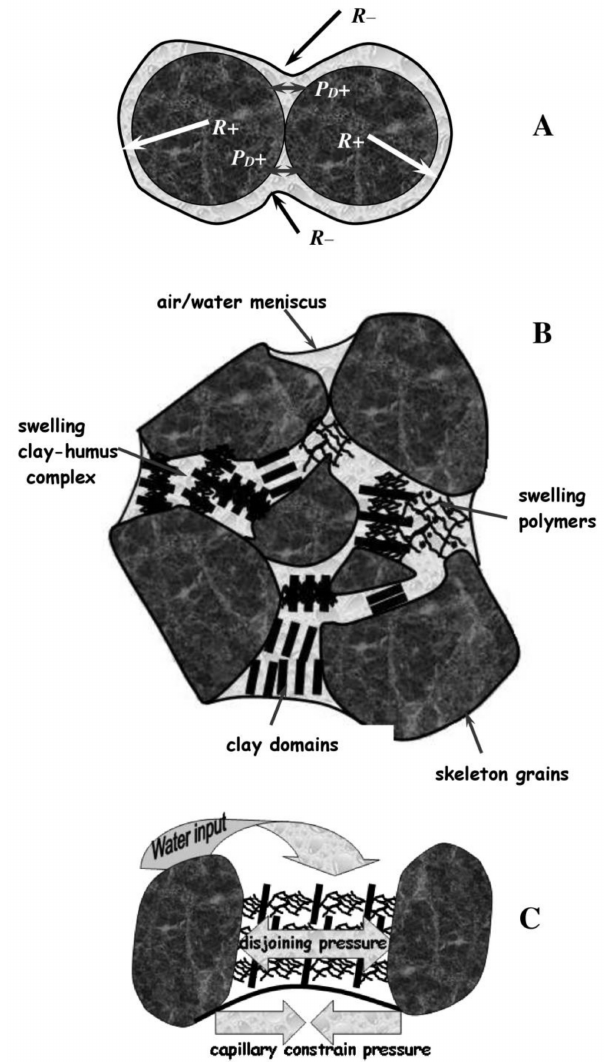
Figure 2. The equilibrium pattern of film and capillary water. ( A ) Coarse textured soils, ( B ) swellable soils with a two-phase colloid-dispersed complex (clay domains, swelling polymers, swelling clay- humus complex), ( C ) the effect of disjoining pressure of soil